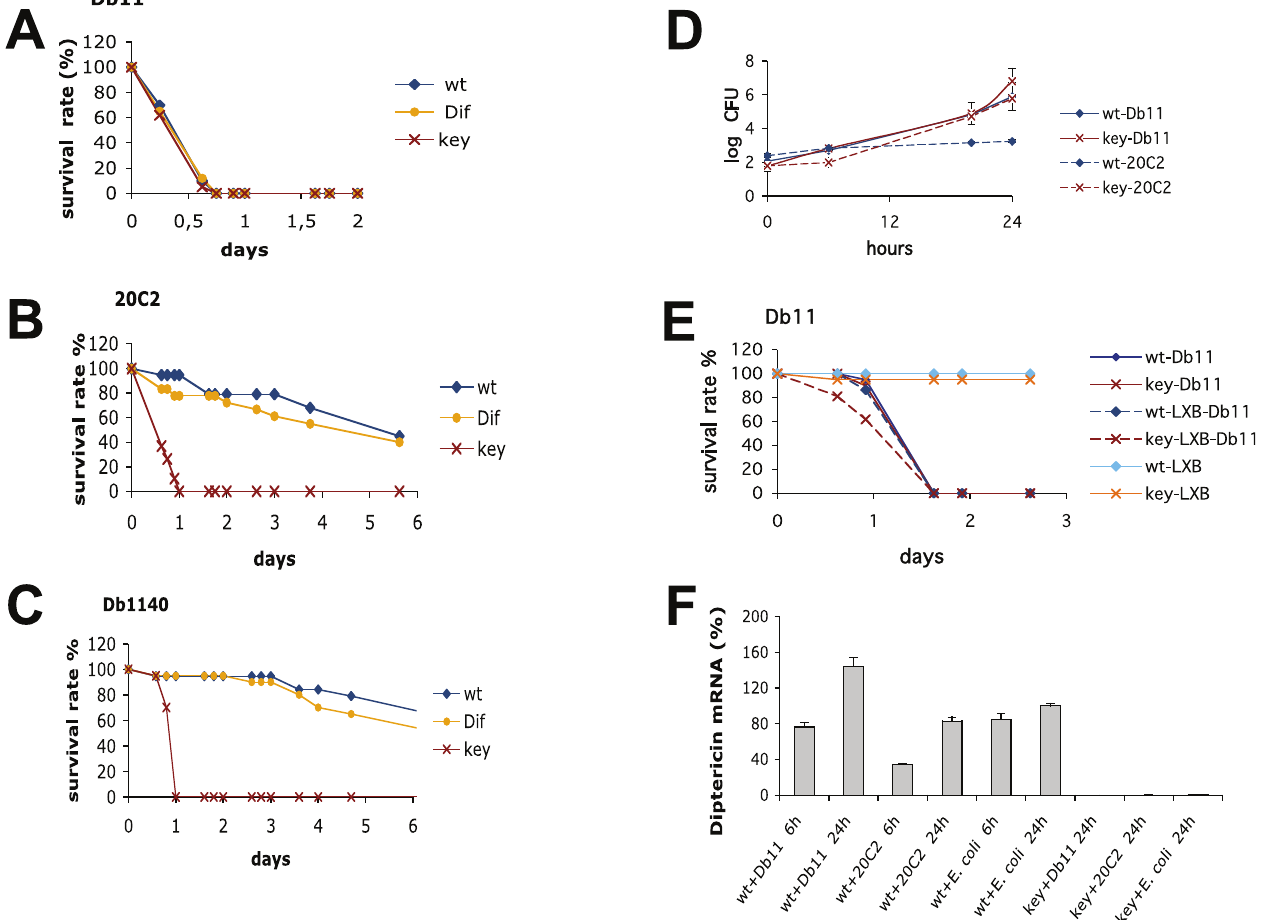
Figure 1. S. marcescens Is Resistant to the Humoral Immune Response in the Septic Injury Model (A–C) Wild-type (wt), Dif , or key flies were pricked using a thin needle dipped in a diluted overnight culture of Db11 (A), 20C2 (B), or Db1140 (C) (OD 600 ¼ 0.1) to introduce about 100 bacteria per fly. Flies were kept at 25 8 C. Survival was monitored and expressed in % of surviving flies. Note that 20C2 and Db1140 kill key flies while they are less virulent in wild-type or Dif flies. (D) The hemolymph of pricked flies incubated was collected and spread on agar plates containing the appropriate antibiotic. The experiment was performed at 20 8 C to insure that we would obtain enough surviving flies at the late time points of the experiment. 20C2 bacteria are kept in check in the hemolymph of wild-type, but not key flies. CFU: colony-forming units (logarithmic scale). (E) Flies were either preinjected with latex beads (LXB) or nontreated and then submitted to an immune challenge with Db11, except for nonchallenged controls. Survival was monitored at 20 8 C. (F) Diptericin expression was induced in wild-type flies at 20 8 C after pricking with Db11 or 20C2 but not in key mutant flies. Diptericin mRNA levels were measured by quantitative RT-PCR. The expression induced 24 h after an E. coli septic injury is taken as a reference. Dif flies exhibited normal induction of Diptericin after S. marcescens septic injury (not shown).